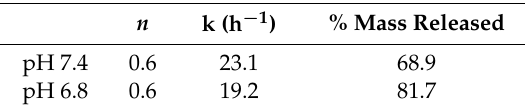
Table 3. Peppas’ Adjustment for IBP (Ibuprofen) release.